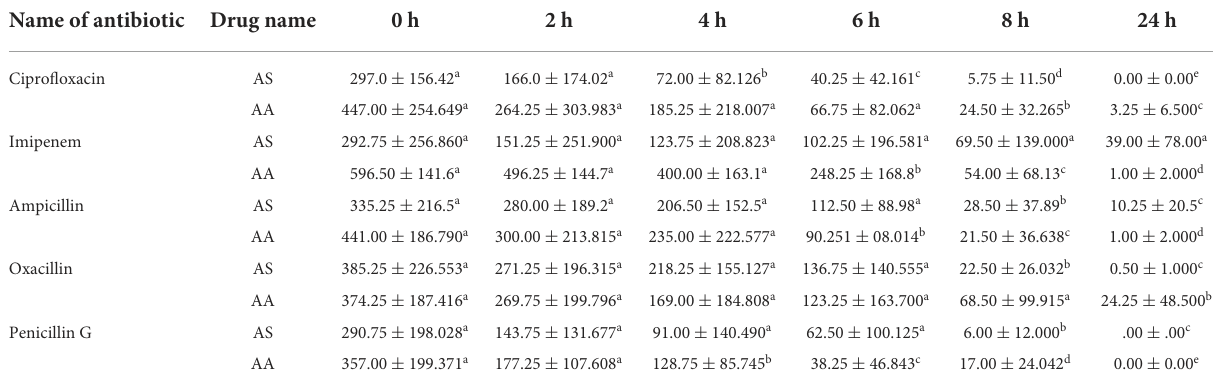
TABLE 7 Comparison of the time-kill assay (bacterial count) under the effect of ART and DHA. Name of antibiotic